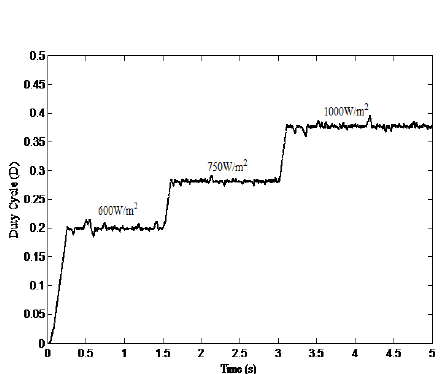
Fig. 17: Variable step size Duty